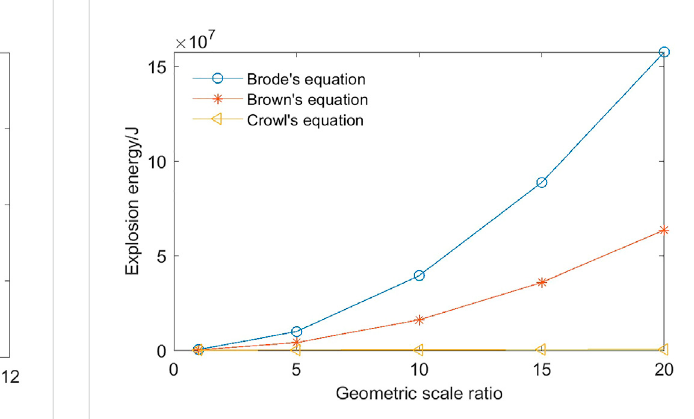
FIGURE 4 Explosion energy for envelopes with different geometric scale ratios calculated by Brode ’ s, Brown ’ s, and Crowl ’ s